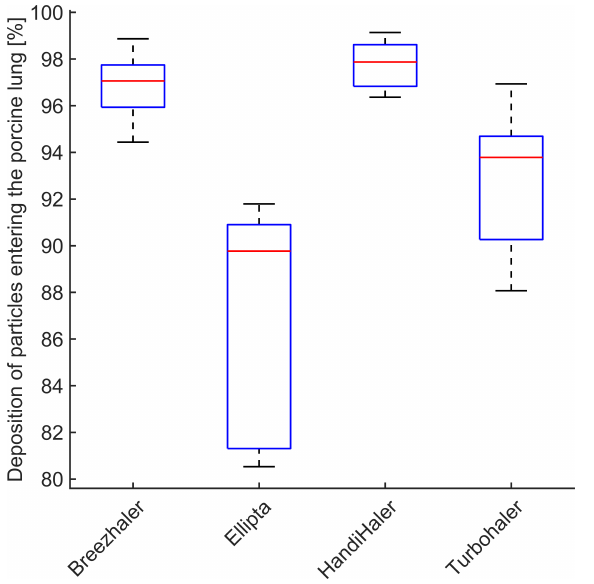
Figure 6. Deposition of aerosol particles in the porcine lung (expressed as a percentage of particle number concentration measured posterior of the mechanical UAM) for four commercial DPI inhalers.